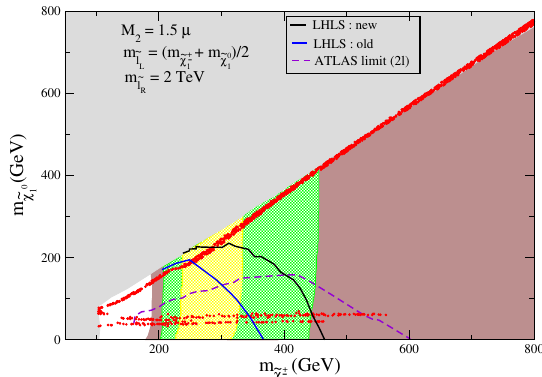
Figure 4 . Plot in m (cid:0) m plane in Light Higgsino and light Left Slepton (LHLS) model. The (cid:6) e (cid:31) 0 1 e (cid:31) 1 black contour is for the non-decoupled scenario whereas the blue one is for the decoupled scenario (see text for details). The purple dashed line represents the exclusion contour from ATLAS slepton searches [60]. Colors and conventions are same as in (cid:12)gure